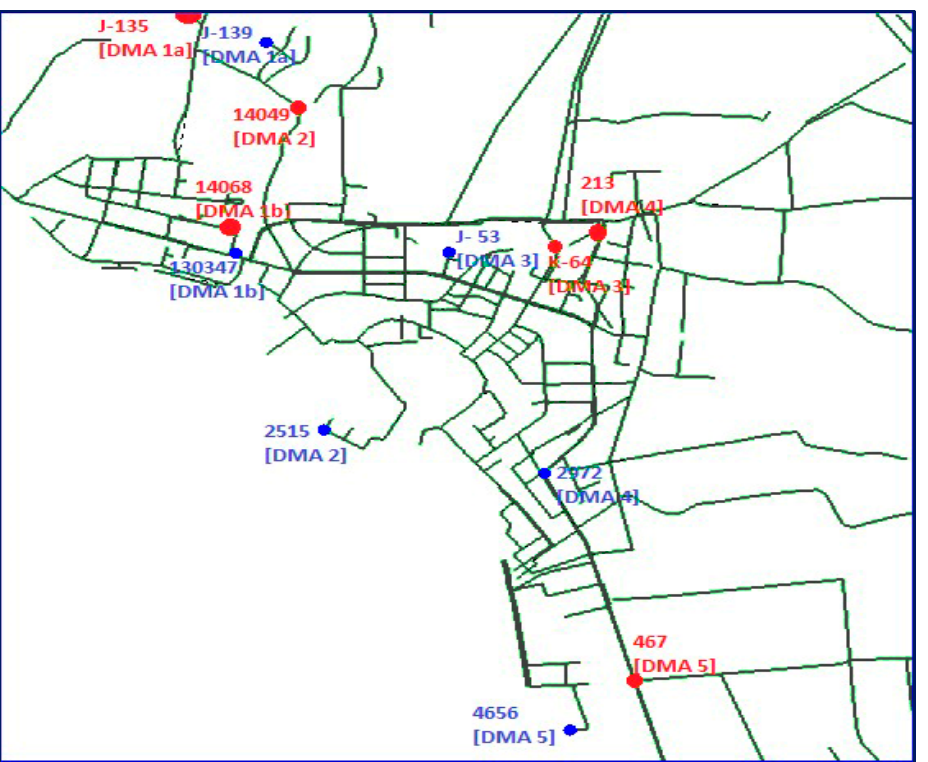
Figure 4. Scenario No2_Pressure critical nodes (red) vs. Age critical nodes (blue). Table 3. Scenario No3 (with DMAs_with PRVs): a) Critical nodes per DMA based on the water pressure. Respective water age and water demand values; b) Critical nodes per DMA based on the water age. Respective water pressure and demand values.